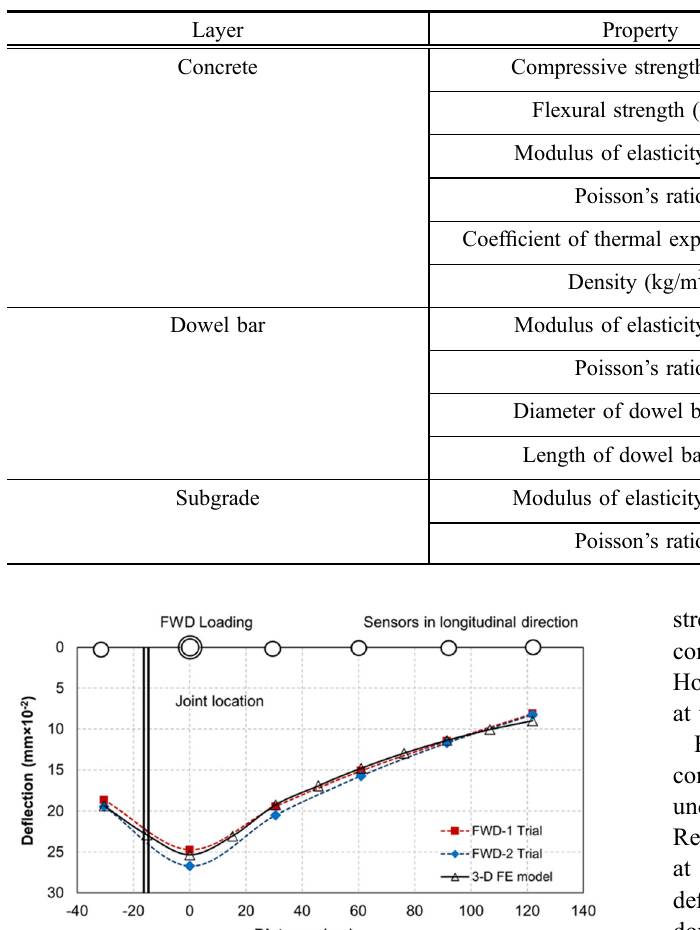
Table 3 Material properties used in the FE model.